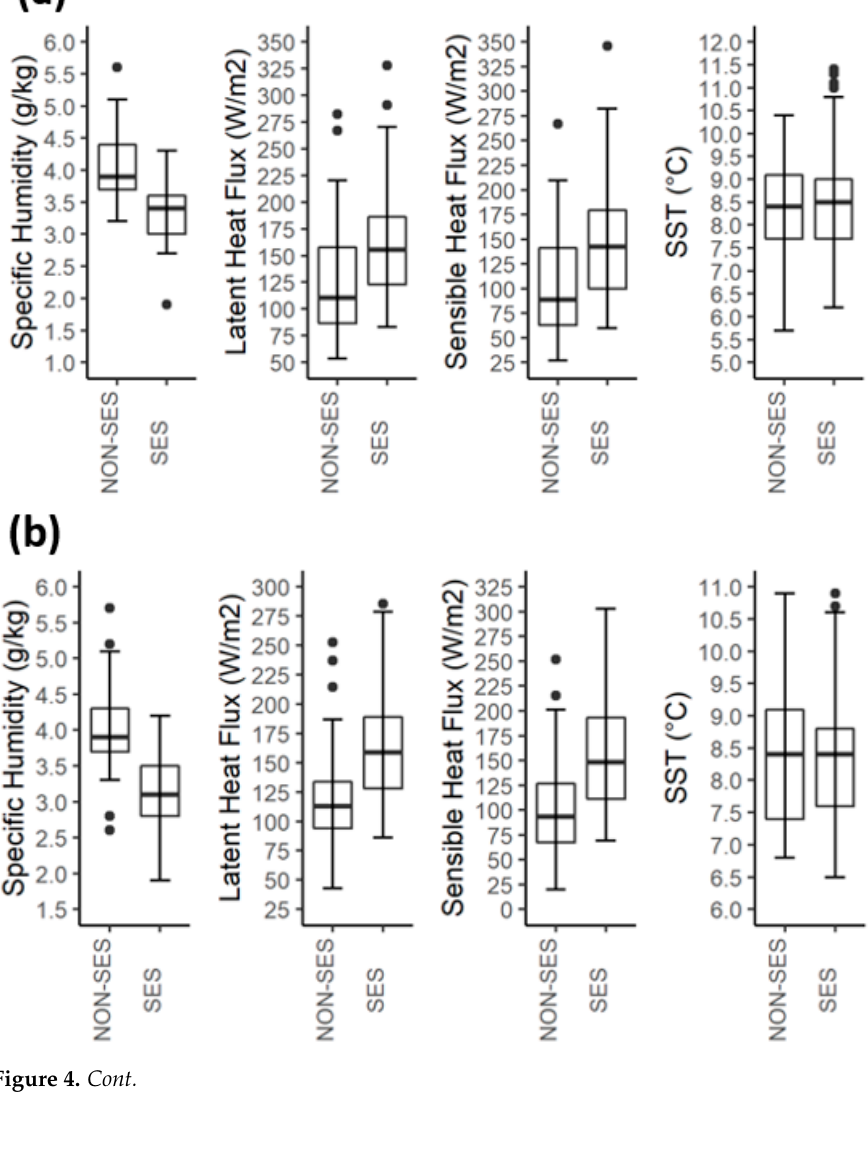
Figure 4. Changes in meteorological parameters in SES and non-SES events at ( a ) point “A”, ( b ) point “B”, and ( c ) point “C” on the western Black Sea surface. Specific humidity values were observed to be between 17.5% and 22.5% lower in SES events than in non-SES events at all three points. The highest mean values were observed at point “A” and the lowest values at point “C”. The average latent heat flux values were 27% higher at point “A”, 37% higher at point “B”, and 25% higher at point “C” in SES events compared to non-SES events. The average sensible heat flux values were found to be 27% higher at point “A”, 37% at point “B”, and 25% higher at point “C” in SES events compared to non-SES events. In both heat fluxes, the highest values in SES events were observed at point “C” and the lowest values at point “A”. In SST values, the average value in SES events was determined as 8.5 °C at all three points. Relatively lower average values (2–3% less) were found in non-SES events. The results obtained in this section, especially regarding heat fluxes, are similar to those of many studies in the literature [38,56,58,59]. Lang and co-workers stated that in cases of sufficient fetch distance, the wind speed varies